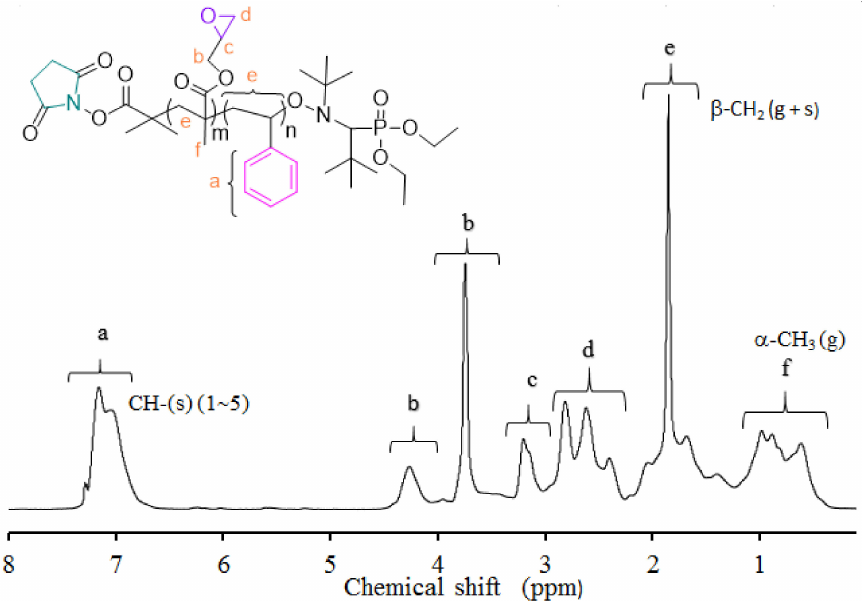
Figure 3. Representative 1 H-NMR spectrum for P(S-co-GMA) copolymers synthesized by NMP.